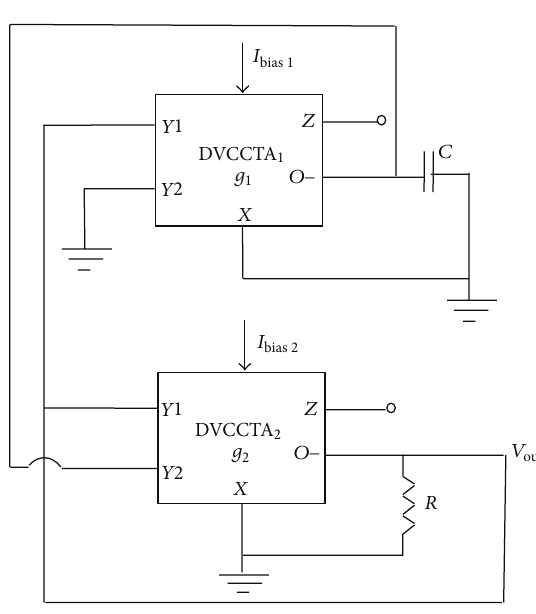
Figure 4: Proposed DVCCTA based pulse